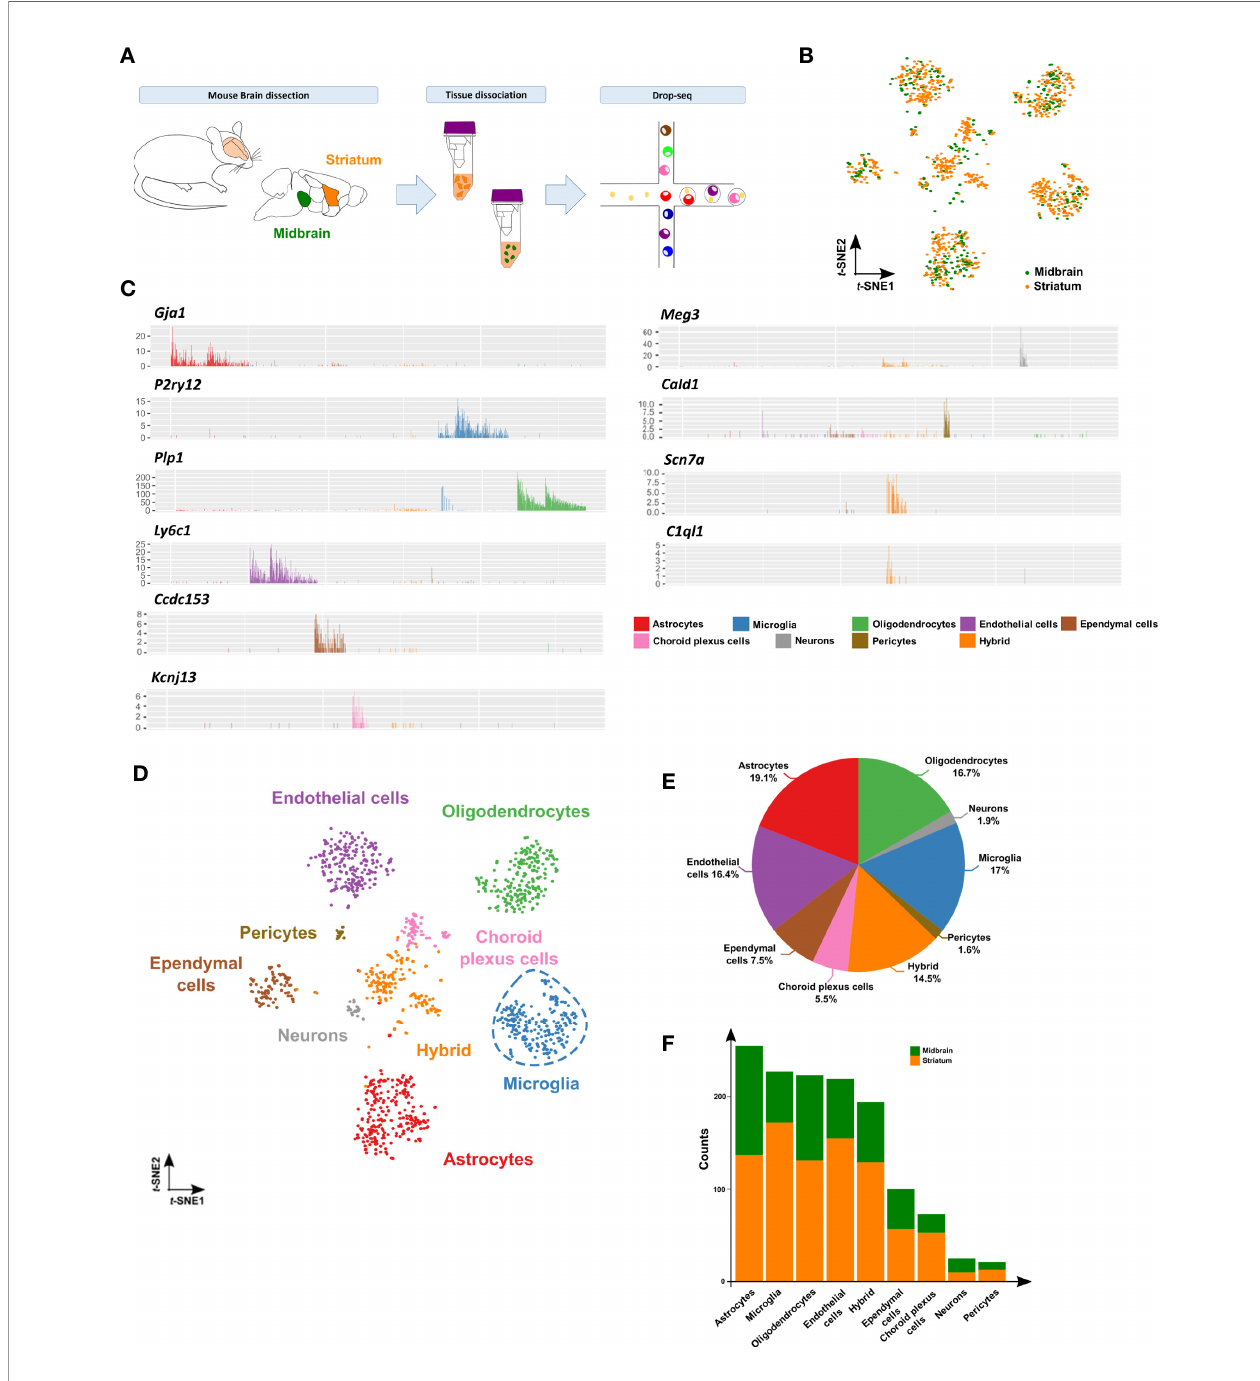
FIGURE 1 | Single-cell transcriptomics identi fi es cellular diversity of the midbrain and striatum. (A) Schematic representation of the experimental approach. Tissue dissected and dissociated from midbrain (in green) and striatum (in orange) of six months-old C57BL/6J mice (pool of 5 mice) analyzed by Drop-seq. (B) t -SNE projection of 1,337 single cells included in the study showing 480 cells isolated from midbrain (in green) and 857 cells from striatum (in orange). (C) Bar plots of representative cell type-speci fi c markers across nine identi fi ed clusters: microglia ( P2ry12 ), astrocytes ( Gja1 ), oligodendrocytes (P lp1 ), endothelial cells (L y6c1 ), hybrid ( Scn7a and C1ql1) , ependymal cells ( Ccdc153 ), choroid plexus cells ( Kcnj13 ), neurons/neuronal stem cells ( Meg3 and Snhg11 ) and pericytes ( Cald1 , Vtn , Notch3 ) clusters. See Figure S1 and Table S1 for additional cell type-speci fi c markers used for cluster annotation. (D) Annotated clusters in the t -SNE map showing nine speci fi c groups identi fi ed by differential expression analysis featuring 15,446 total genes (FDR<0.05): microglia (in blue), astrocytes (in red), oligodendrocytes (in green), endothelial cells (in purple), hybrid (orange), ependymal cells (brown), choroid plexus cells (in pink), neurons/neuronal stem cells (in grey) and pericytes (in pale brown). (E) Pie chart depicting the percentage of the identi fi ed cell types. (F) Bar plot showing proportion of cell types within midbrain (in green) and striatum (in